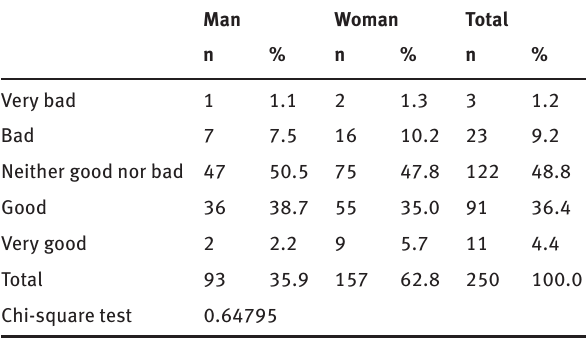
Table 7: Answers to general WHOQOL questions (how satisfied